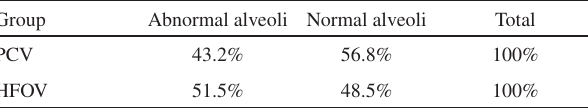
Table 3 - Alveolar architecture changes according to the type of ventilatory strategy. Abnormal alveoli were collapsed or hyperinflated. Values expressed as